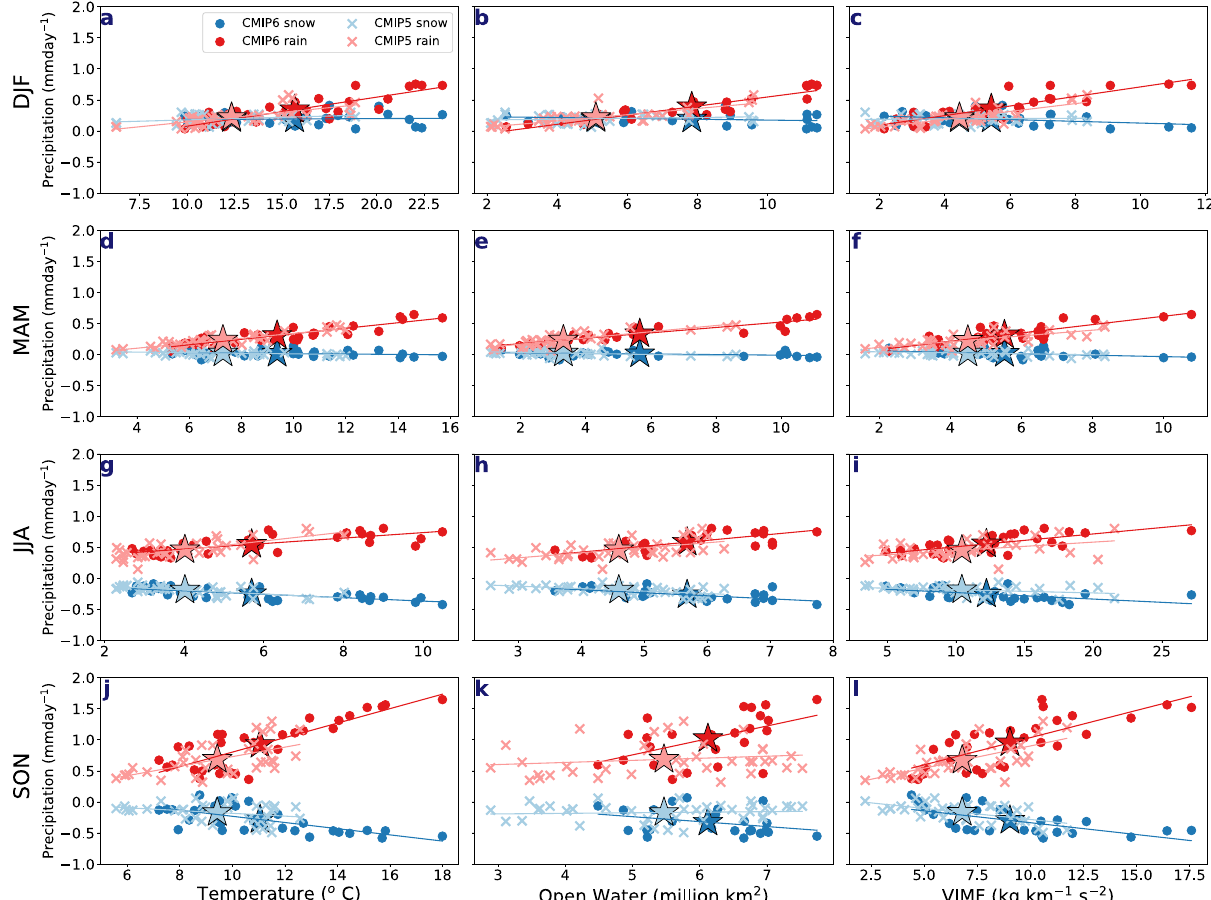
Fig. 5 Model-dependent end-of-century changes in snowfall and rainfall for SSP5 – 8.5/RCP8.5 forcing. Inter-model dependence of snowfall and rainfall to a , d , g , j surface air temperature, b , e , h , k Open water and c , f , i , l vertically integrated moisture fl ux (VIMF) changes at the end of the century relative to the start of the century for a – c December – February (DJF), d – f March – May (MAM), g – i June – August (JJA), j – l September – November (SON). Each dot represents a model from CMIP6 and each x represents a model from CMIP5. The stars represent the multi-model means for either CMIP6 and CMIP5 snowfall/rainfall in the same colours as their representative individual members. The line of best fi t is calculated using a 1D